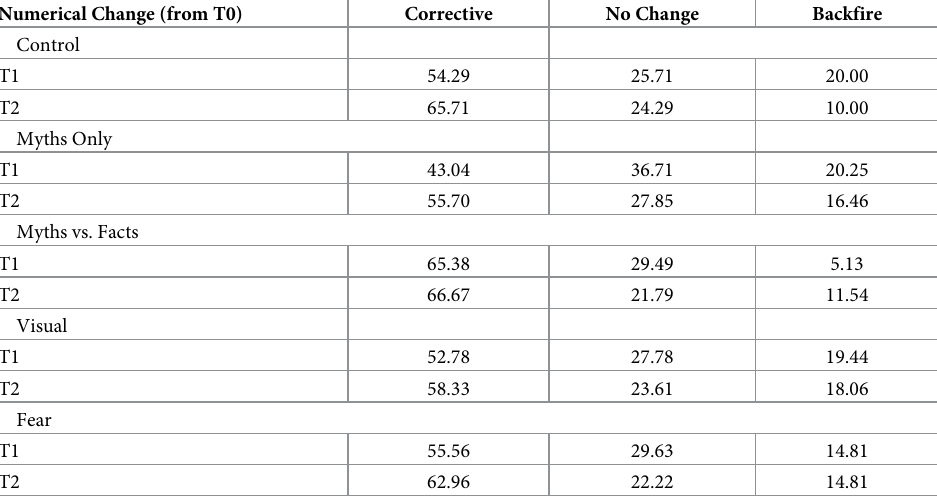
Table 4. Proportions of numerical change tendencies (in %) across conditions and